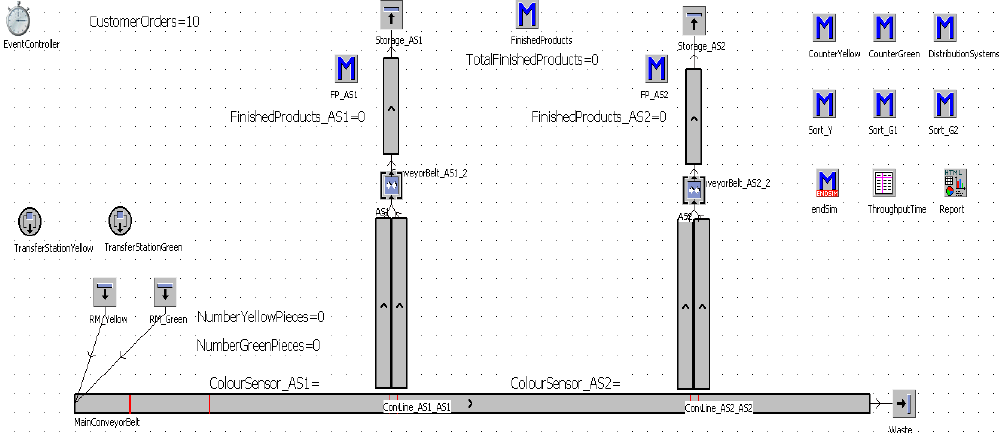
Figure 5. Lego ® Model using Tecnomatix Plant Simulation 11.0 .